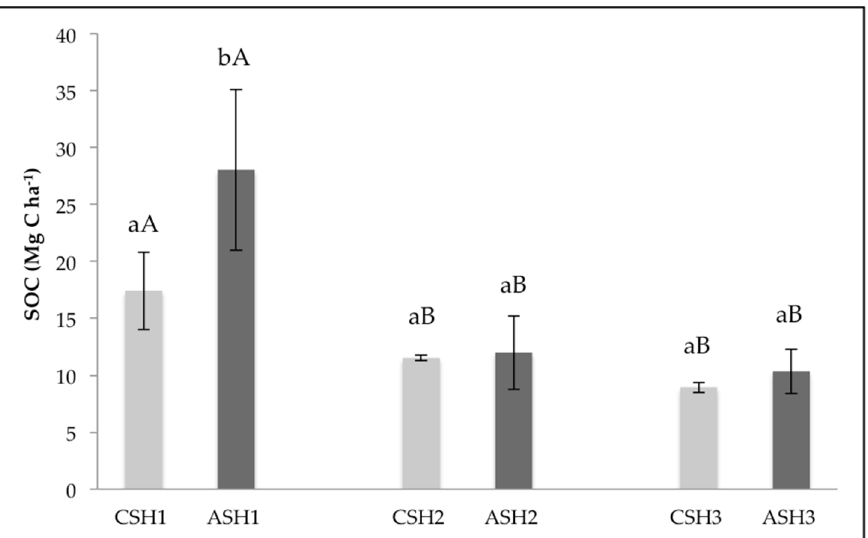
Figure 6. Values of SOC (Mg C ha − 1 ) in each horizon (H1: 0–10 cm; H2: 10–20 cm; H3: 20–30 cm) of cultivated soils (CS) and abandoned soils (AS). Different small letters indicate significant differences between the same horizon of different land use (Wilcoxon’s test, p < 0.05). Different capital letters indicate significant differences between different horizons with the same land use. (Kruskal–Wallis test and the Mann–Whitney U-test, p < 0.05).